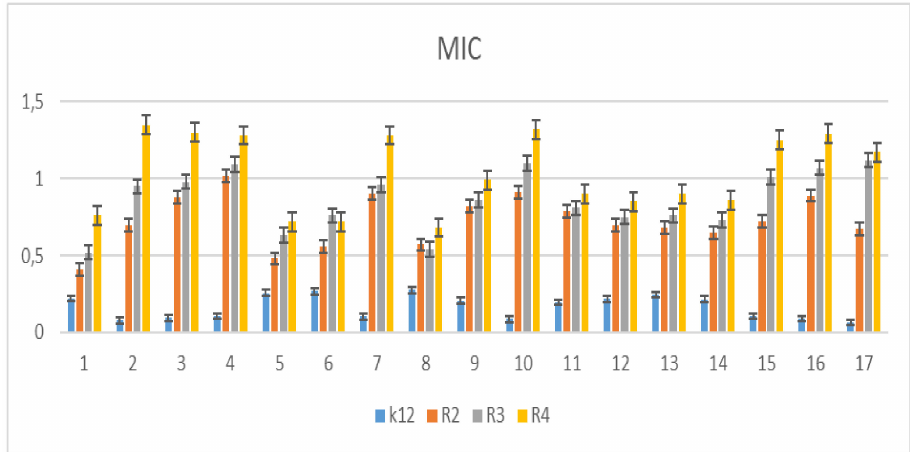
Figure 3. Minimum inhibitory concentration (MIC) of the coumarin derivatives in model bacterial strains. The x -axis features coumarin derivatives 1 – 17 used sequentially. The y -axis shows the MIC value in µ g/mL − 1 . Investigated strains of E. coli K12 as control (blue), R2 strains (orange), R3 strain (grey), and R4 strain (yellow). The y -axis shows the MBC value in µ g/mL − 1 . The order in which the compounds were applied to the plate are shown in Supplementary Materials Figure